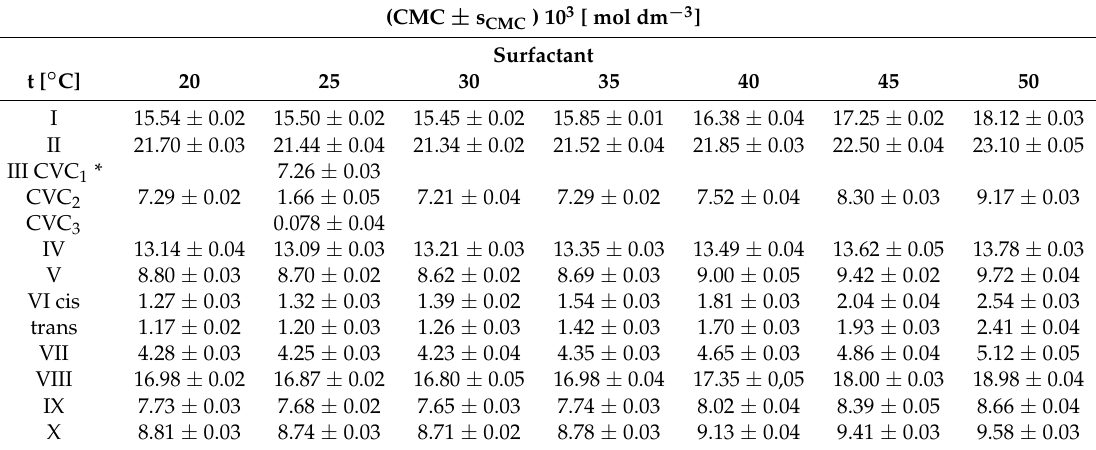
Table 2. Calculated values of critical micellar concentrations (CMC) of all studied surfactants at temperature 20–50 °C.